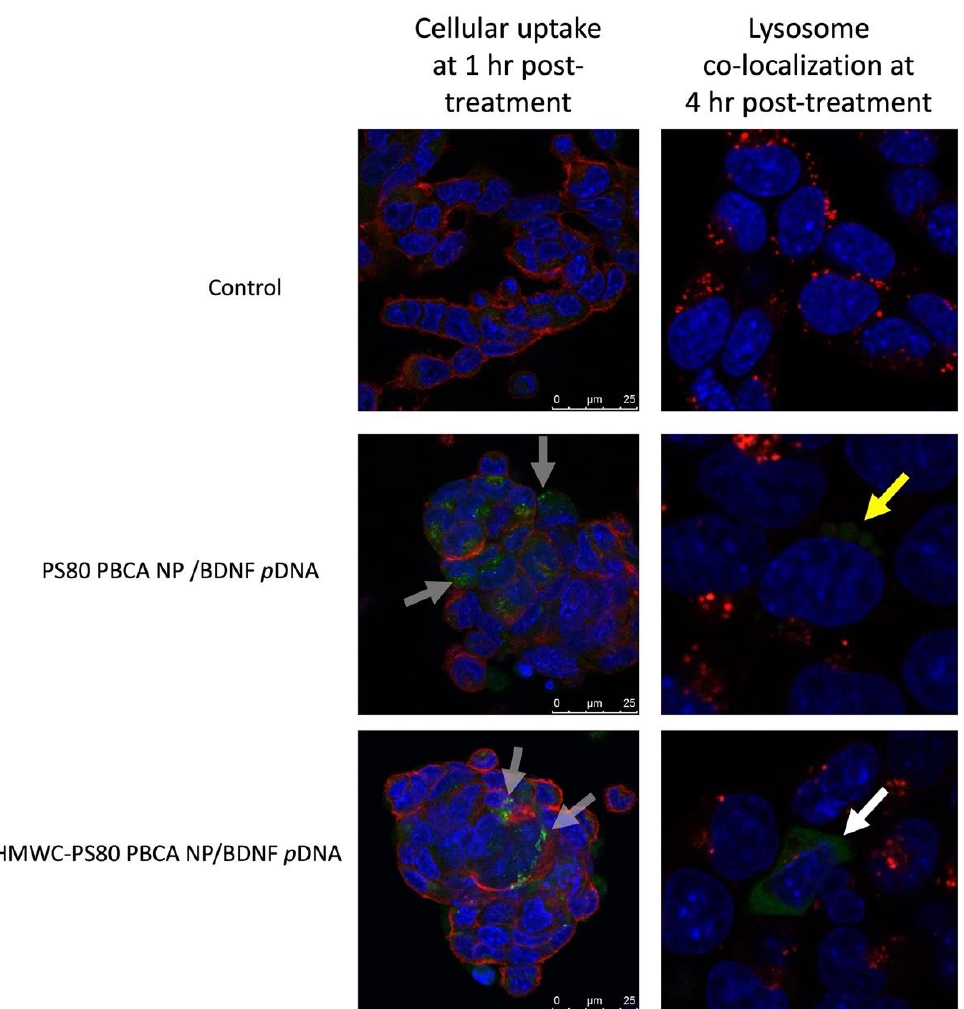
Figure 9. The cellular uptake (left column) and lysosome co-localization (right column) of FITC- dextran-tagged polyplexes were imaged by confocal microscopy. The cellular uptake study was performed at 1 h post-treatment with DAPI and WGA 594 for nuclear and cell membrane staining respectively, both PS80 PBCA NP/BDNF p DNA and HMWC-PS80 PBCA NP/BDNF p DNA polyplexes appeared as dense granules in the cytoplasm (gray arrows). The lysosome co-localization study was performed at 4 h post-treatment with Hoechst 33342 and LysoTraker TM Red DND-99 for nuclear and lysosome staining, respectively. PS80 PBCA NP/BDNF p DNA polyplex remained co-localized in the lysosome (yellow arrow), whereas HMWC-PS80 PBCA NP/BDNF p DNA appeared widely distributed in the cytoplasm (white arrow).